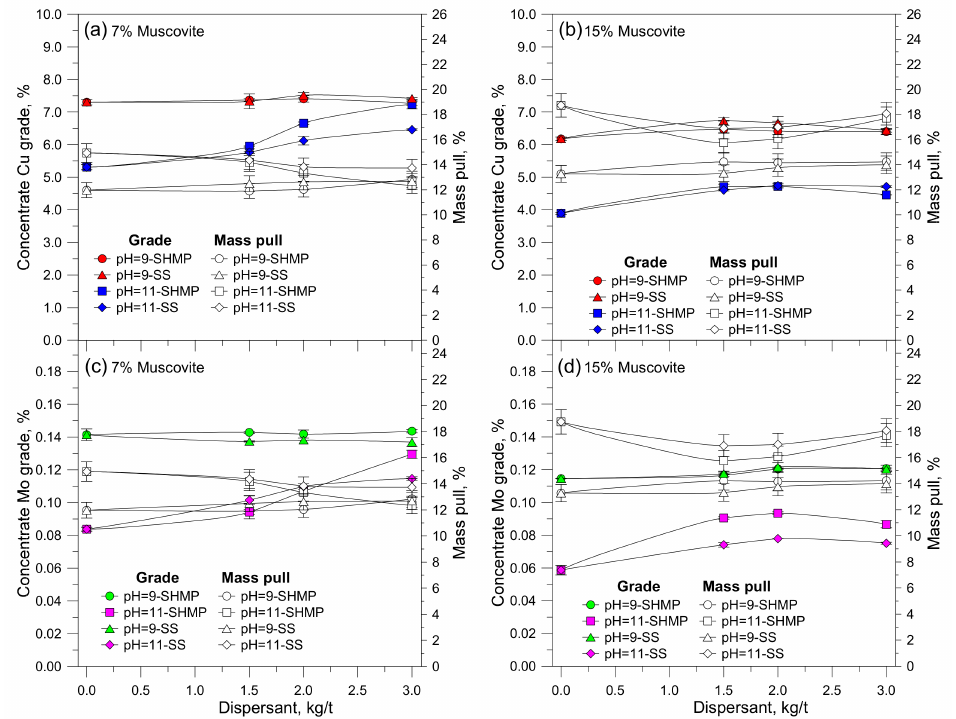
Figure 3. Copper ( a , b ) and molybdenum ( c,d ) concentrate grades and mass pull in seawater at pH 9 and 11, as a function of dispersant dosage (SHMP, SS), and two muscovite contents.